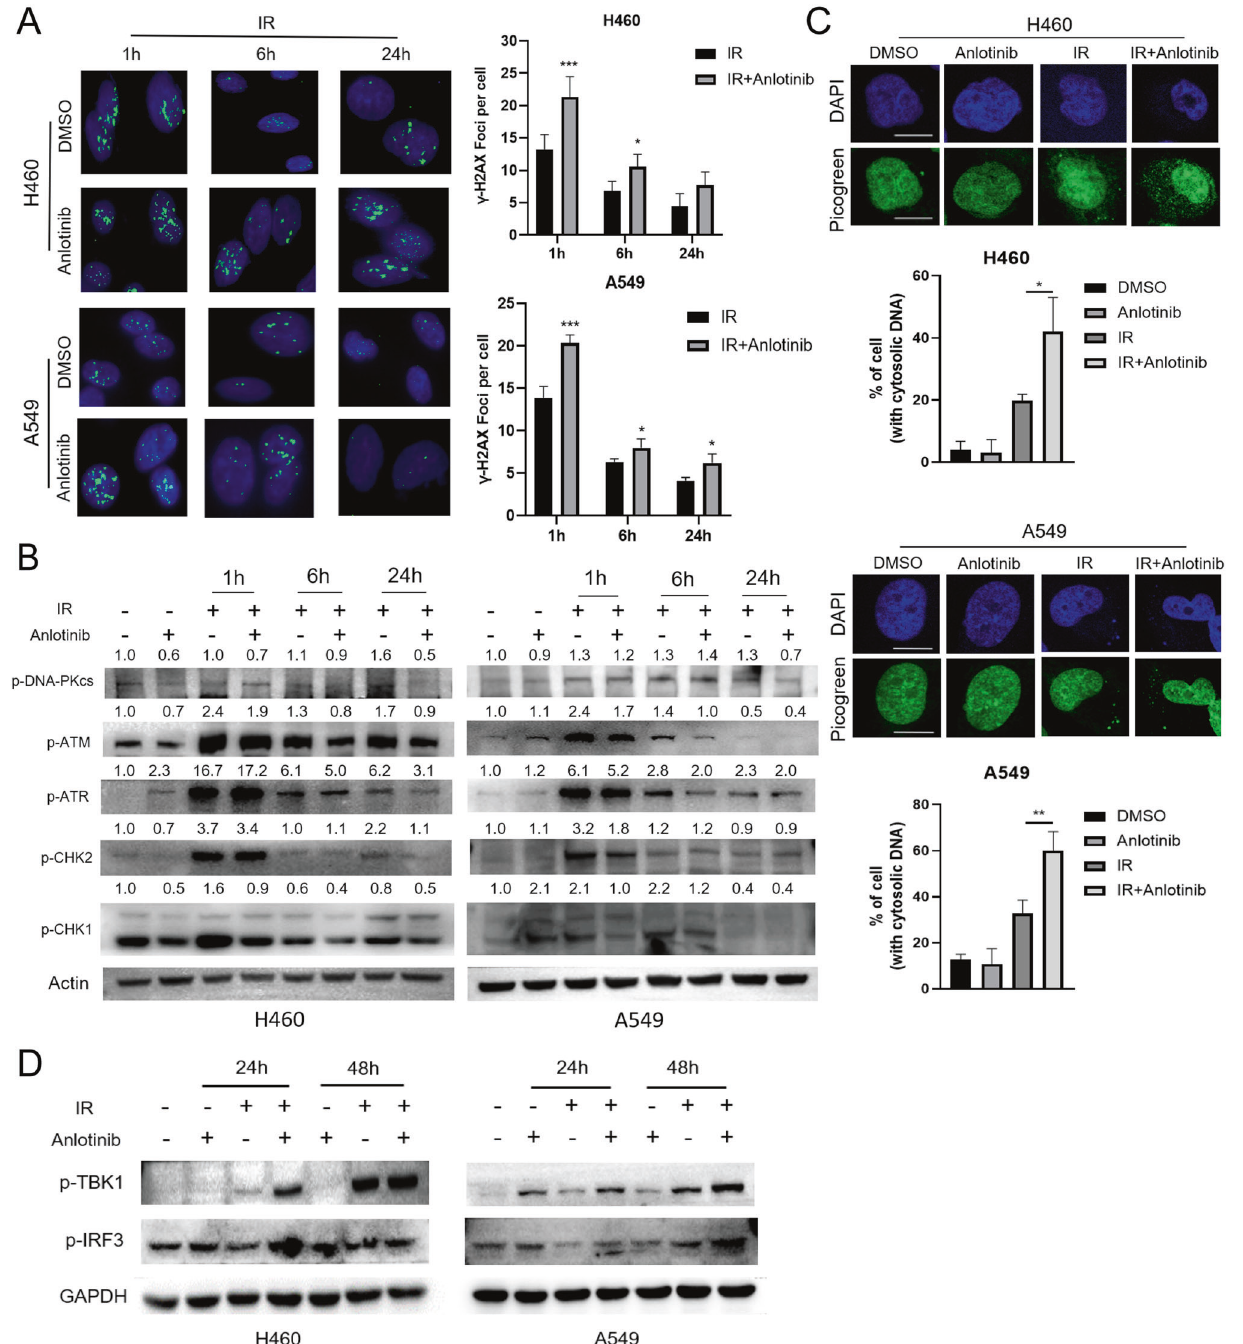
Fig. 2 Anlotinib inhibits repair of IR-induced DNA double-strand breaks and enhances activation of STING pathway. A Detection of γ -H2AX foci was performed at the indicated time point after irradiation (4 Gy). Data are expressed as the mean ± standard deviation. Student ’ s t test. B Expression levels of phosphorylated DNA-PKcs, ATM, ATR, CHK2, and CHK1 were detected at the indicated time point after irradiation (4 Gy). Western blot quanti fi cation of phosphorylated DNA-PKcs, ATM, ATR, CHK2, and CHK1, normalized to Actin. Results are shown as a representative of n = 3 independent repeats. C Representative images and quantitative analysis of PicoGreen staining. Cells with cytosolic DNA were counted. Scale bar, 10 μ m. Student ’ s t test. D Western blot revealed that anlotinib combined with IR increased the expression of p-TBK1 and p-IRF3. * p < 0.05, ** p < 0.01, *** p <